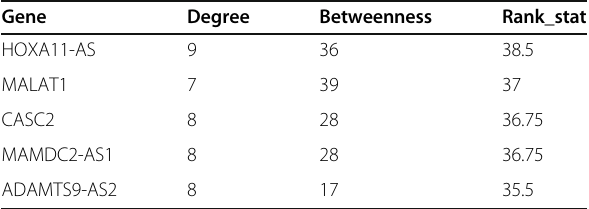
Table 4 The degree of betweenness centrality and rank-stat values of each candidated lncRNAs in the network Gene